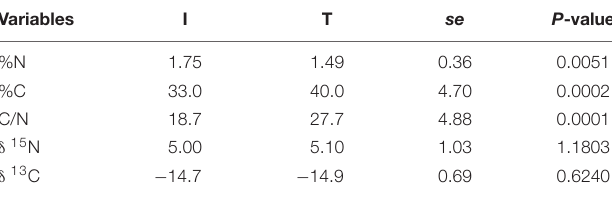
Significance determined using the general linear model (GLM). ( − ) Not detectable. TABLE 2 | Stable isotope values ( δ 13 C, δ 15 N) and C/N ratio from cattle feces of I (semi-intensive) and T (traditional) beef production systems.